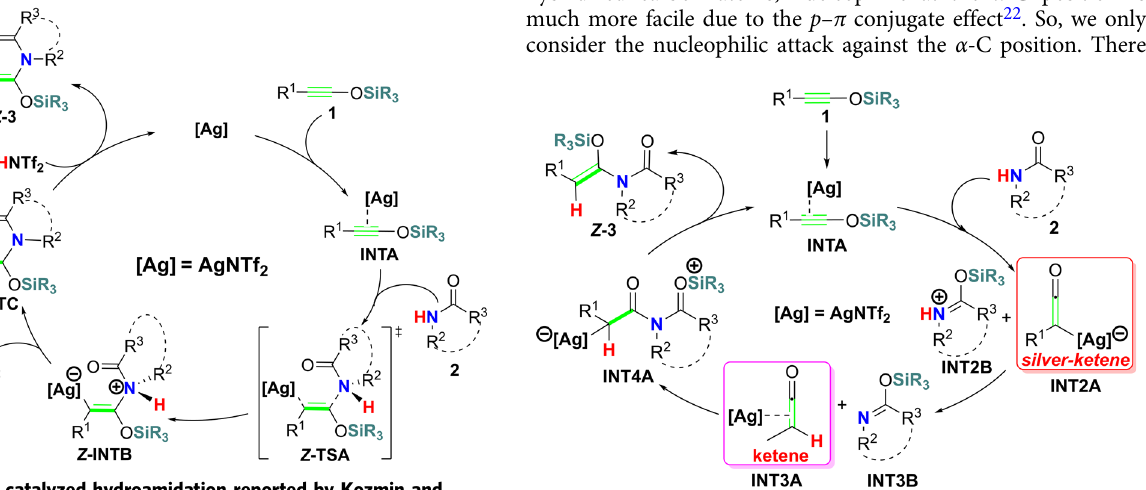
Fig. 1 Silver(I) catalyzed hydroamidation reported by Kozmin and colleagues. a Hydroamidation of siloxy-alkynes. b Ag + induced nucleophilic addition (SNU) mechanism.